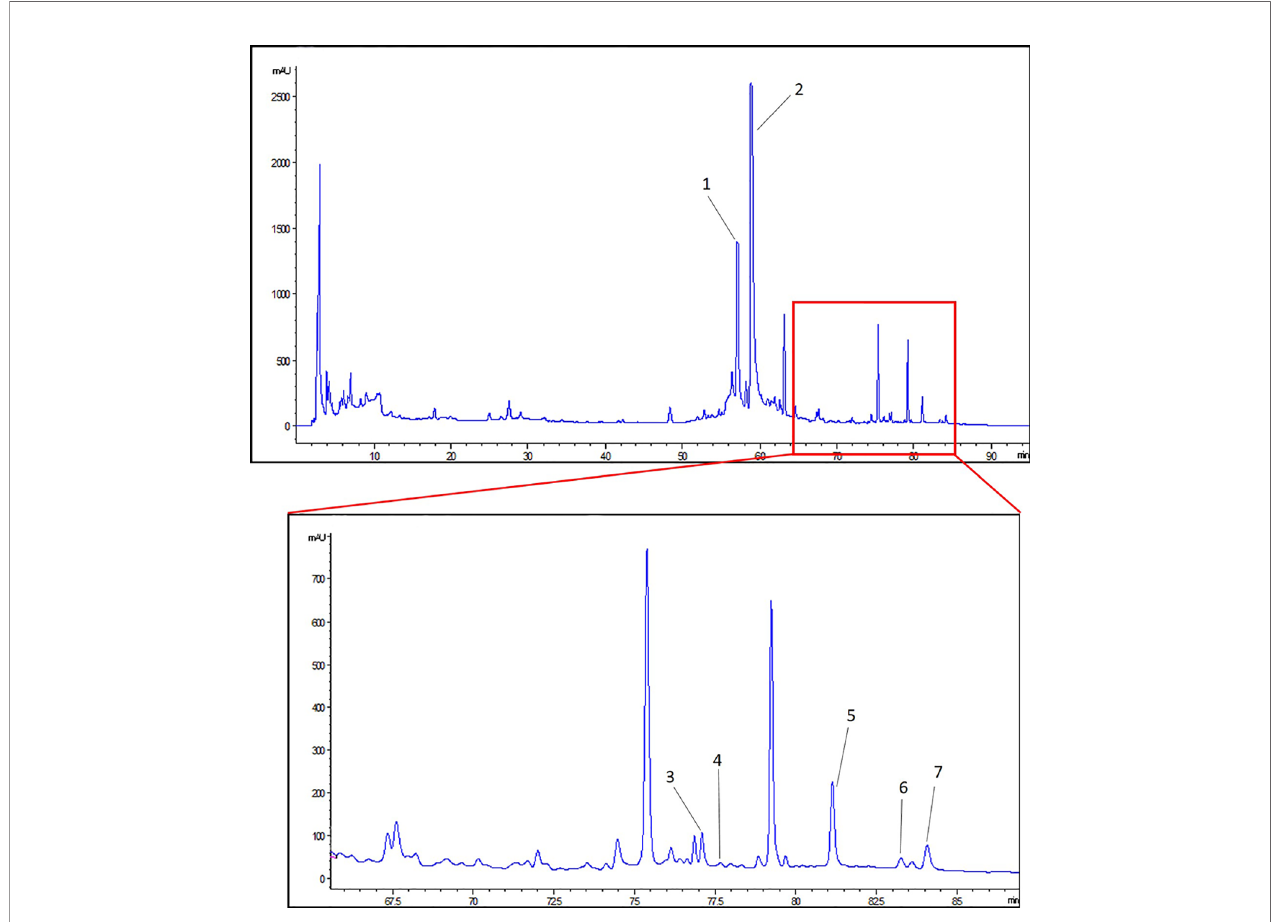
FIGURE 1 | HPLC analysis of Zhen-wu-tang (ZWT). (1) 6-gingerol, (2) paeoni fl orin, (3) benzoylaconine, (4) benzoylhypacoitine, (5) atractylenolide III, (6) pachymic acid, and (7) atractylenolide II.